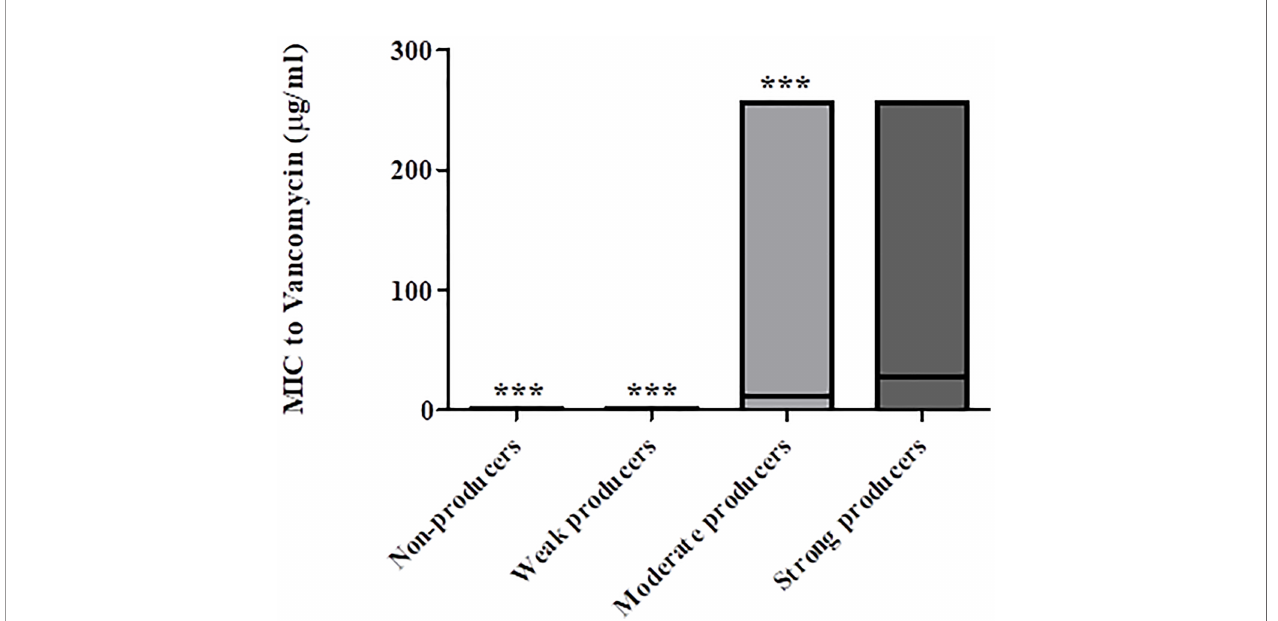
FIGURE 4 | Distribution of vancomycin MIC values of non-bio fi lm producers, weak-, moderate- and strong bio fi lm producers. The minimal, maximal and average MIC values are shown (the average is indicated by the line within the bar) for each group of isolates (non-producers, weak-, moderate- and strong producers ’ groups). The mean vancomycin MIC of strong bio fi lm producers (n = 29) were signi fi cantly higher as compared to MIC values of isolates that were non-producers (n = 57), weak producers (n = 14) and moderate producers (n = 23), *** p < 0.001. The p value represents the comparison of the mean MIC between the four categories of bio fi lm production capacity (ANOVA